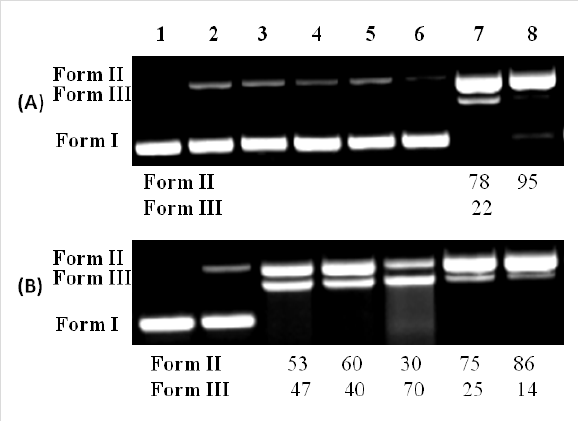
Figure 5: DNA photocleavage of amidoxime carbamates at a concen- tration of 500 μ M and mechanistic studies of aldoxime carbamate 26 . Gel electrophoreses pictures. For (A) and (B) wells 1 and 2 represent DNA in dark and DNA UV irradiated, respectively. Photo (A): wells 3–8: DNA + carbamoyl amidoximes ( 8 or 9 , or 10 , or 11 , or 12 , or 13 , respectively) + UV irradiation; Photo (B): Mechanistic studies involved by derivative 26 under UV irradiation: well 3: DNA + 26 ; well 4: DNA + 26 + argon; well 5: DNA + 26 + DMSO (20%); well 6: DNA + 26 + NaN 3 (20 mM); well 7: DNA + 26 + D 2 O; Legends: The % calculated damage of DNA via its conversion to Form II and Form